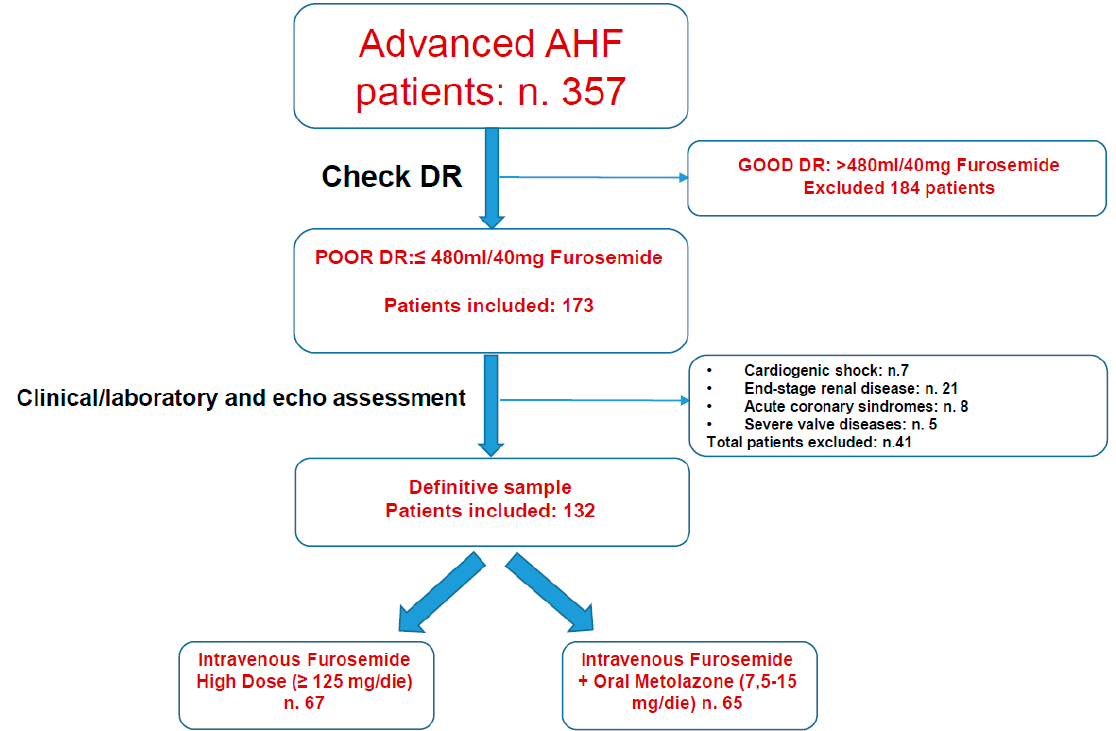
Figure 1. Study protocol screening diagram based on diuretic response.